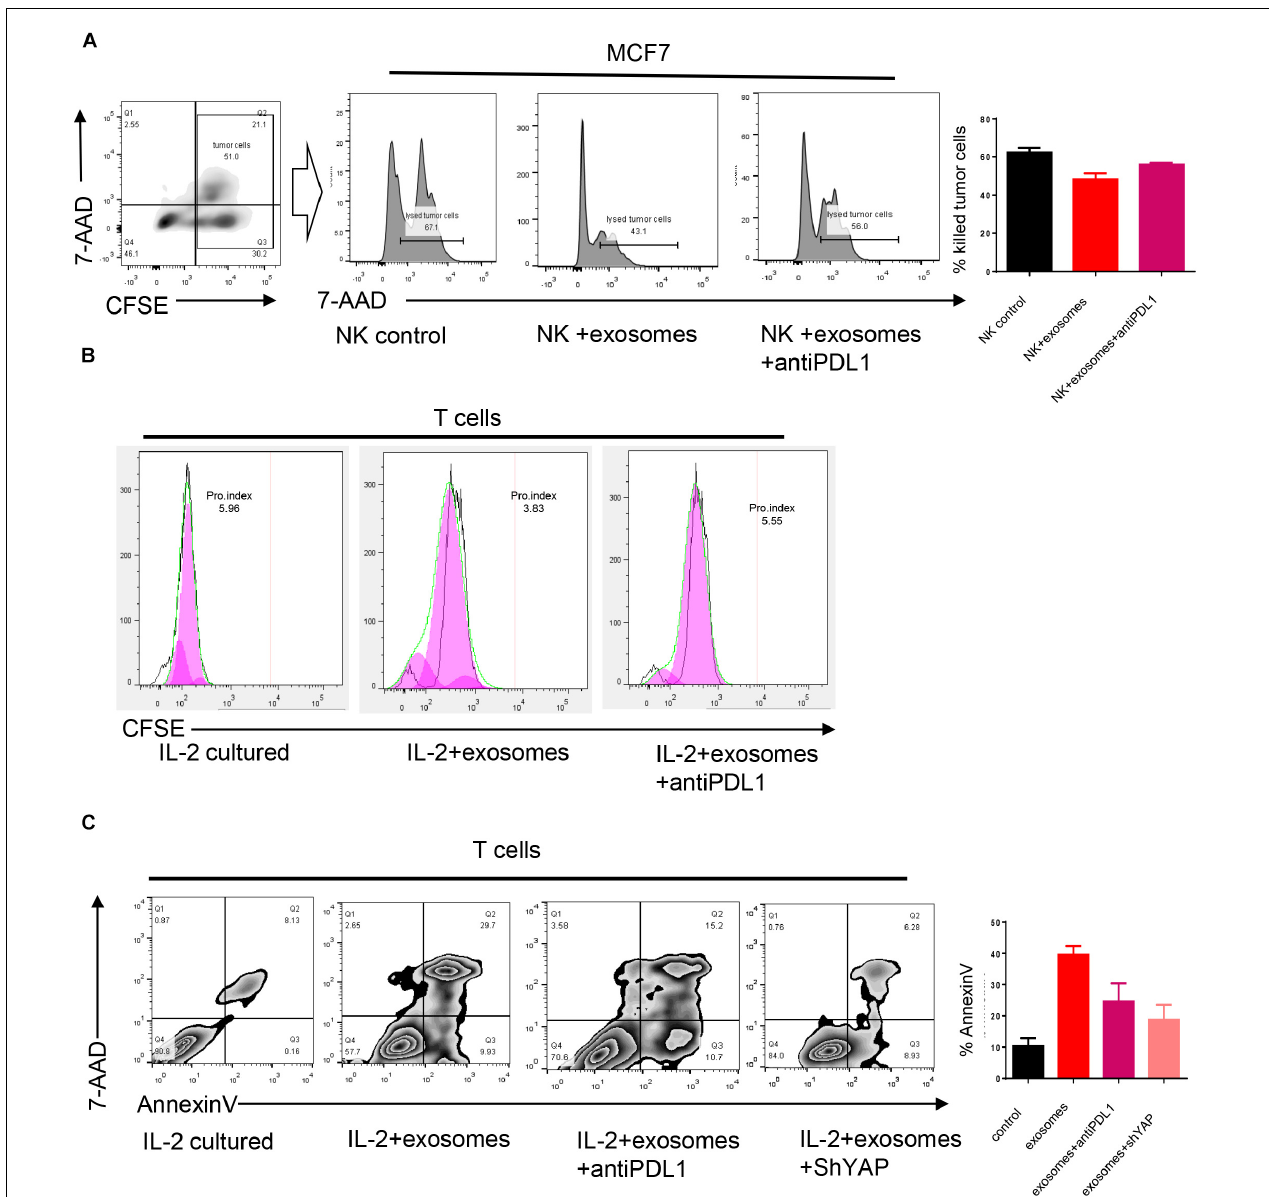
FIGURE 5 | Exosomes induced PD-L1 upregulation suppresses immune cell function in breast cancer. (A) An NK cell cytotoxicity assay was performed, MCF7 treated or untreated by exosomes were used as target cells. The quantification of cytotoxicity of NK cells were shown in right panel. (B) CFSE was used to evaluate the proliferation of T cells. T cells were cultured directly with MCF7 treated or untreated by exosomes for 48 h. (C) T cells were cultured directly with MCF7 treated or untreated by exosomes for 48 h, the apoptosis rate was evaluated by an Annexin V stain. Error bars represent mean ± SD; **** P < 0.0001; n.s., not significant; by paired two-sided Student’s t